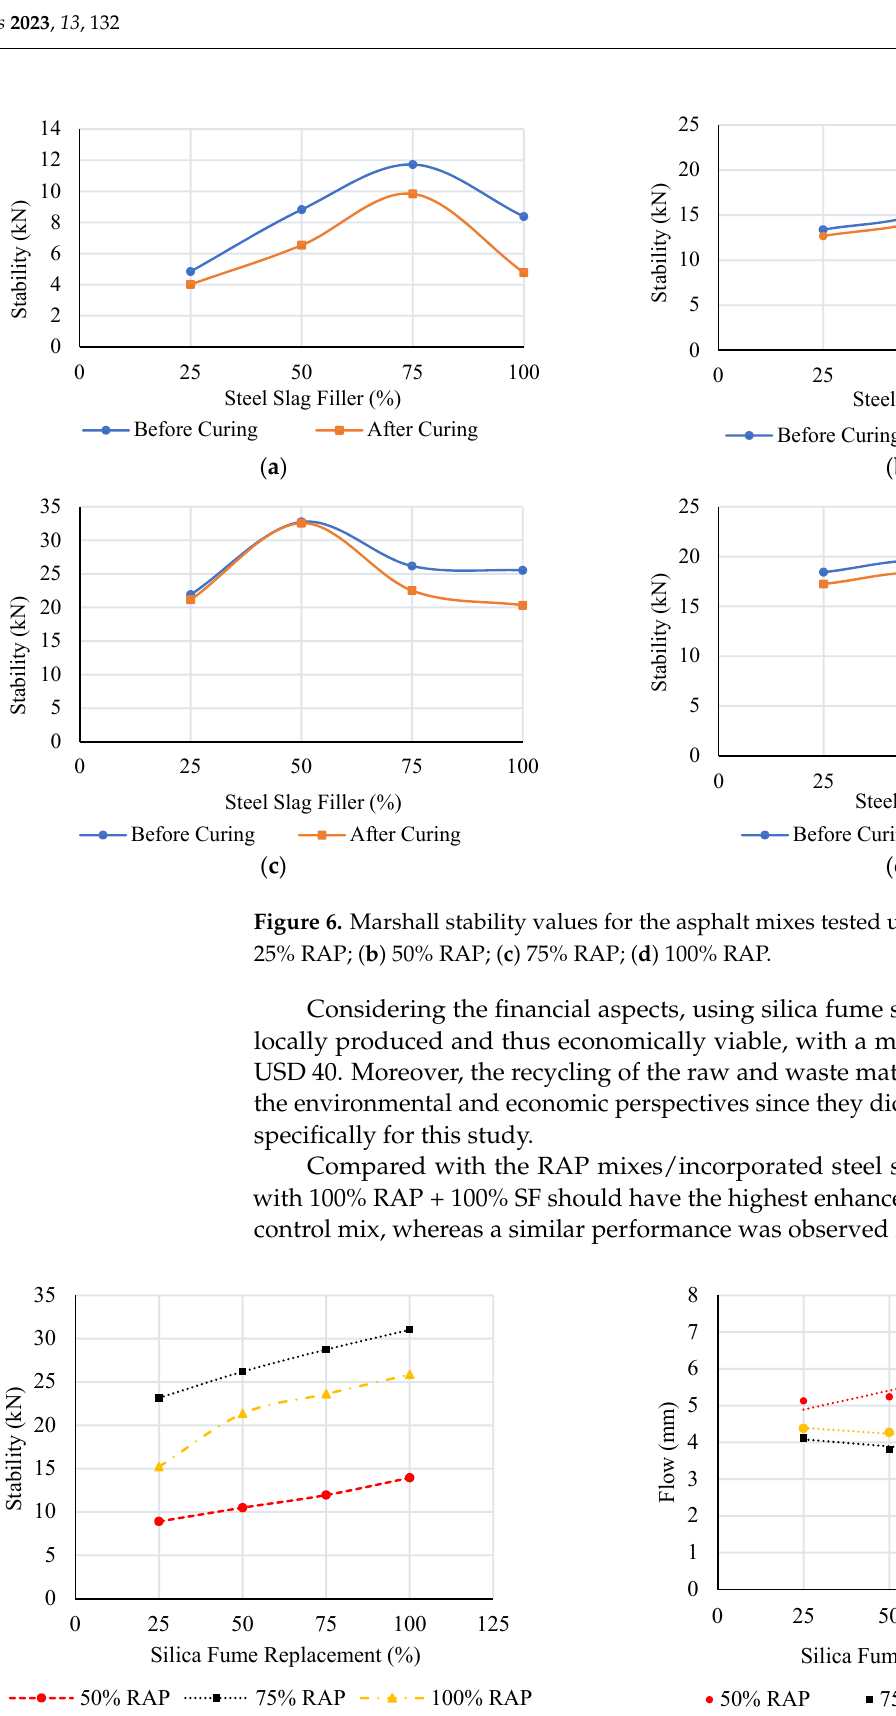
Figure 6. Marshall stability values for the asphalt mixes tested under water and prepared with ( a ) 25% RAP; ( b ) 50% RAP; ( c ) 75% RAP; ( d ) 100% RAP.